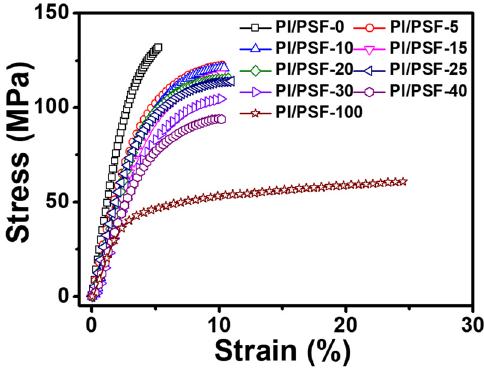
Figure 4: Mechanical properties of PI/PSF - X composite fi lms.